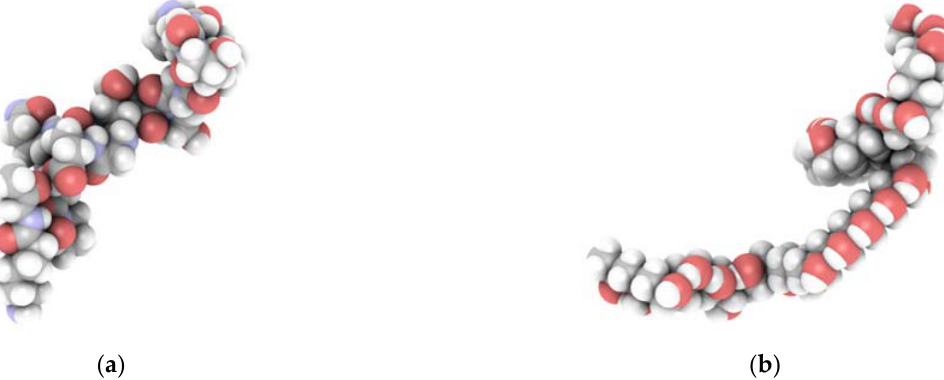
Figure 13. The gelatin ( a ) and PVA ( b ) molecular structures used in the simulation. An appropriate blend of both results in a simulation system under periodic boundary conditions.